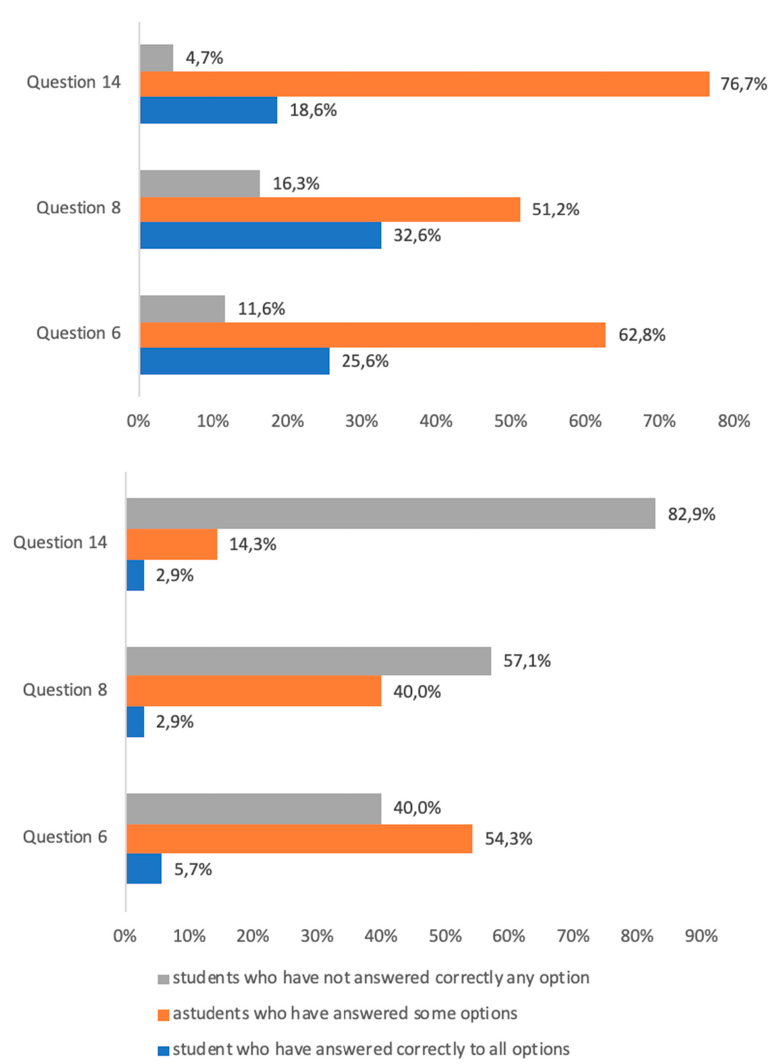
Figure 5. Comparison of the percentage of correct answers in the post-test of both control and experimental groups.